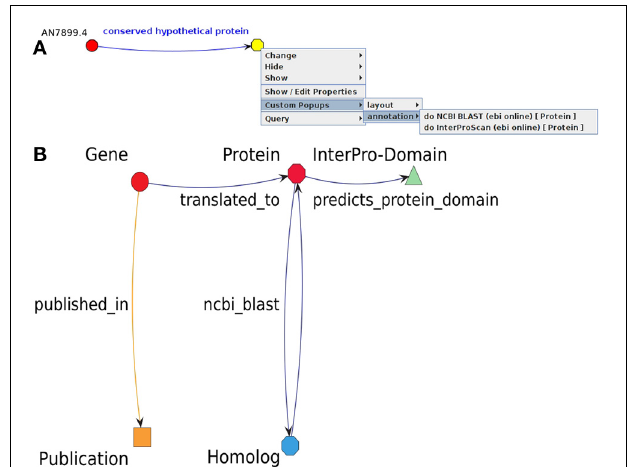
FIGURE 5 | Example application of the context-sensitive menu and meta-legend from the resulting network. (A) Screenshot of context-sensitive menu available for the concept class protein . The protein concept of an associated gene may be either used to invoke an NCBI-BLAST or InterProScan protein domain prediction. (B) Meta-legend of resulting network which has been integrated using the customized context-sensitive menu. The gene names can be used to retrieve publications from PubMed Central or to download protein sequences from the BioMart web service. The protein sequence can be subsequently used to predict the protein domains with the help of InterProScan. Another possibility is to search for similar genes with the help of NCBI-BLAST. A backward BLAST is available in order to provide a bidirectional BLAST to make the prediction of homologs more reliable. All operations are only performed for selected nodes and use web services to integrate up-to-date